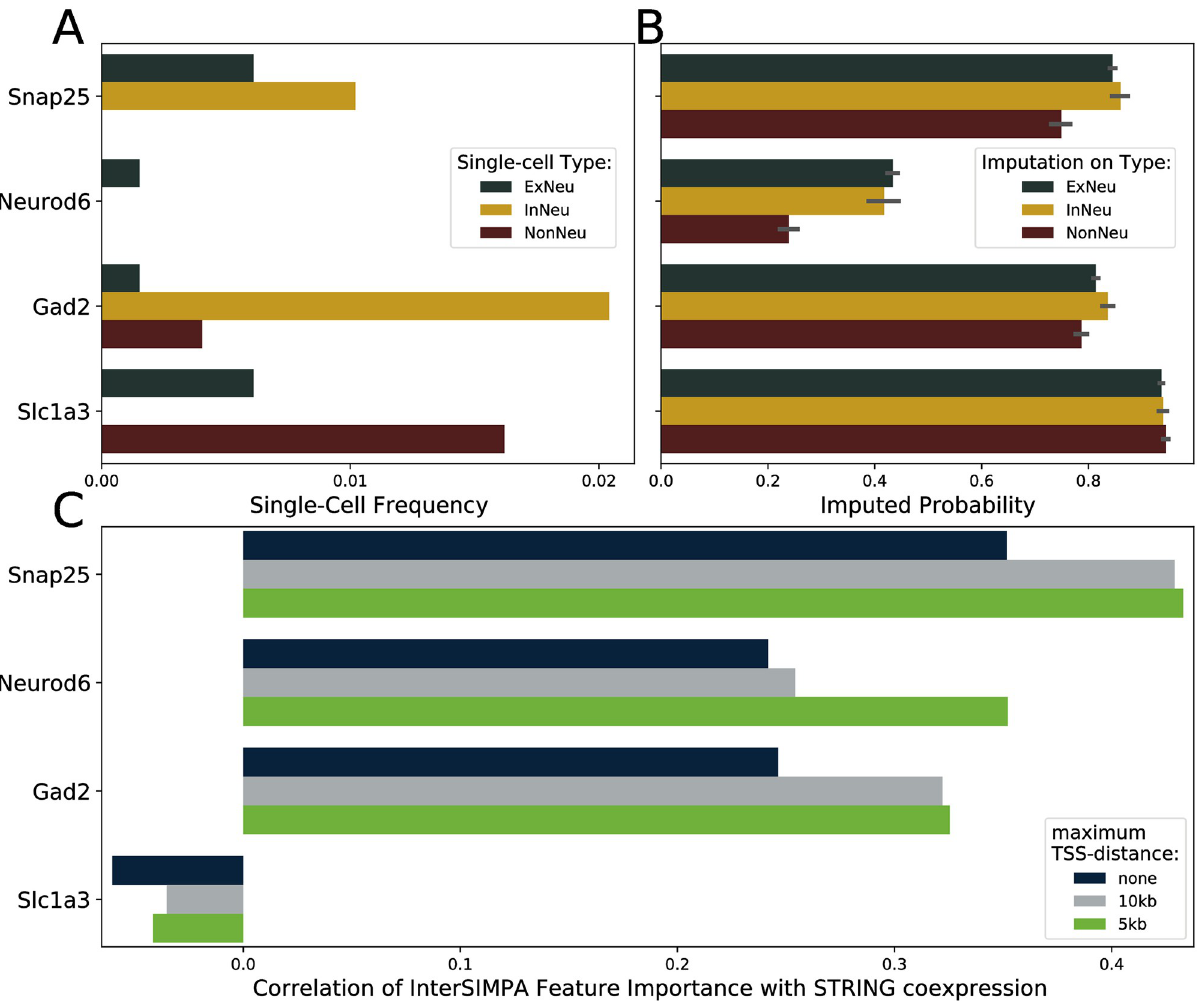
Fig 7. Gene analysis using the interpretation of imputation models. A . Fraction of single cells for which H3K4me3 binding is observed within the gene’s promoter region in the mouse single-cell dataset. Dark green and yellow bars representing excitatory (ExNeu) and inhibitory (InNeu) neurons, respectively. Red bars represent non-neurons (NonNeu). y-axis labels show the gene names. B . Imputed probability computed by SIMPA for the gene- related promoter regions shown in A. The imputation was applied on 1000 single cells in total and the error bars represent the standard deviation across the imputation runs on different cells. C . Correlation of feature importance and co-expression values. For each model used to impute a promoter (y- axis), the training features (genomic bins) were extracted together with their importance value provided by the Random Forest algorithm and annotated with the nearest gene on the genome. As indicated by the figure legend, the selection of genomic bins was either not restricted (none), or restricted by a maximum distance to the transcription start site (TSS) of the nearest gene. Co-expression values, derived from transcriptomic and proteomic measurements of those genes with the gene related to the imputed promoter were retrieved from the STRING database. The Pearson’s correlation coefficient of feature importance and co-expression values is shown